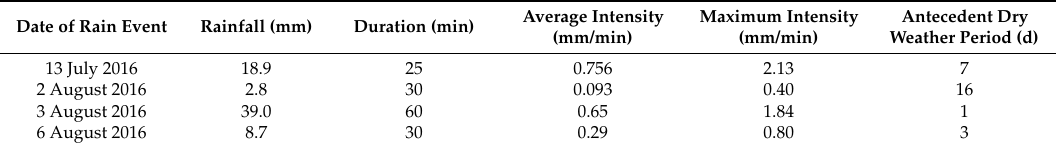
Table 2. Rainfall characteristics from July to August in